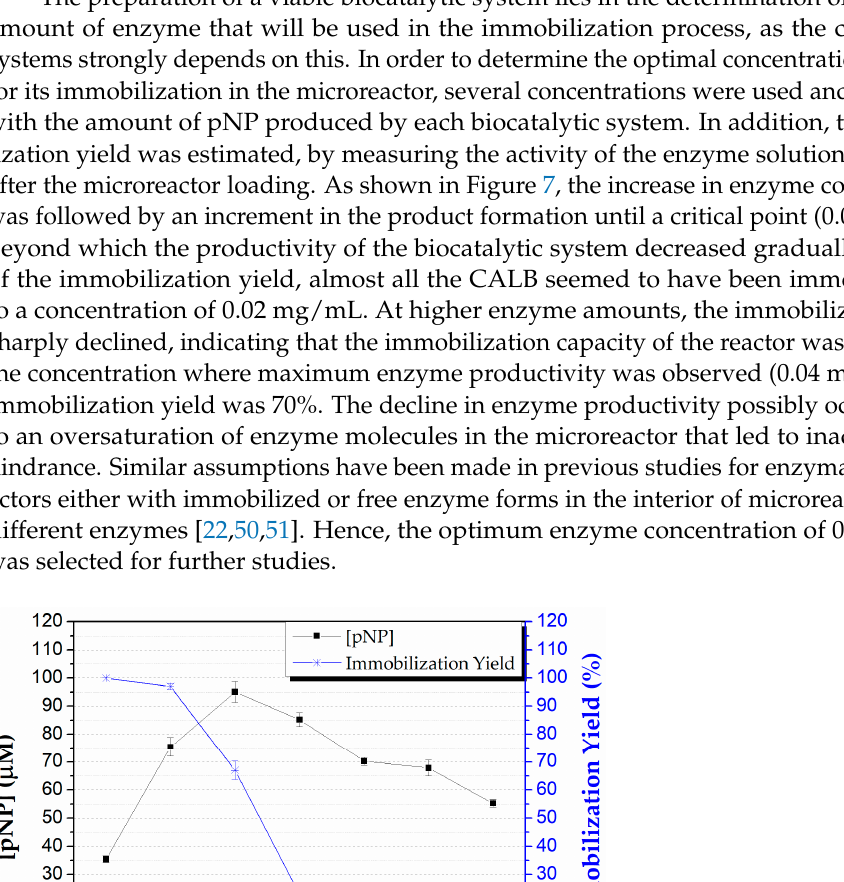
Figure 8. Operational stability of immobilized CALB in PLA microreactors in the absence and the presence of 10% v / v Bet:Gly for 100 cycles of use. Reaction conditions: 0.25 mM pNPB in 50 mM phosphate buffer pH 7.5, 0 or 10% v / v Bet:Gly, 40 °C, flow rate 300 μ L/min ( t R = 30 sec). 3.3.3. Thermal Stability of Immobilized CALB in Microreactor The robustness of the enzymatically modified PLA microreactor was also tested by filling the microreactor with 100% Bet:Gly and incubating at 60 °C. In this manner, the stability of the immobilized lipase would be evaluated, and insight would be gained into the capability of the microbioreactor to be used in synthetic reactions that include this DES. So, at specific points in time, the DES was removed, the microbioreactor was washed